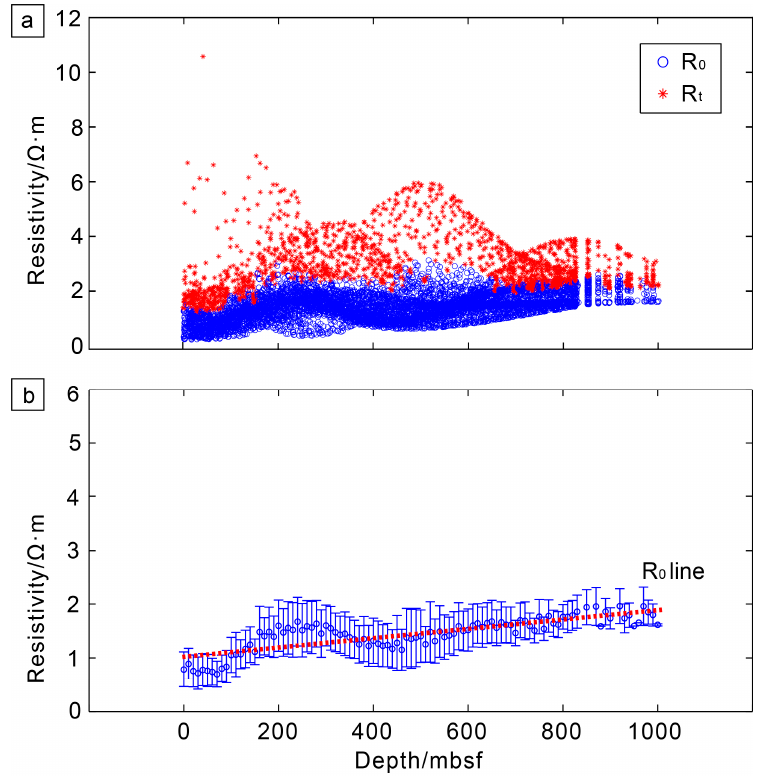
Figure 8. The resistivity of water-saturated sediments ( R 0 ). ( a ) The resistivity was divided into two categories based on the similarities and differences among the data. ( b ) The linear formation resistivity of the pore water saturated sediments ( R 0 line).